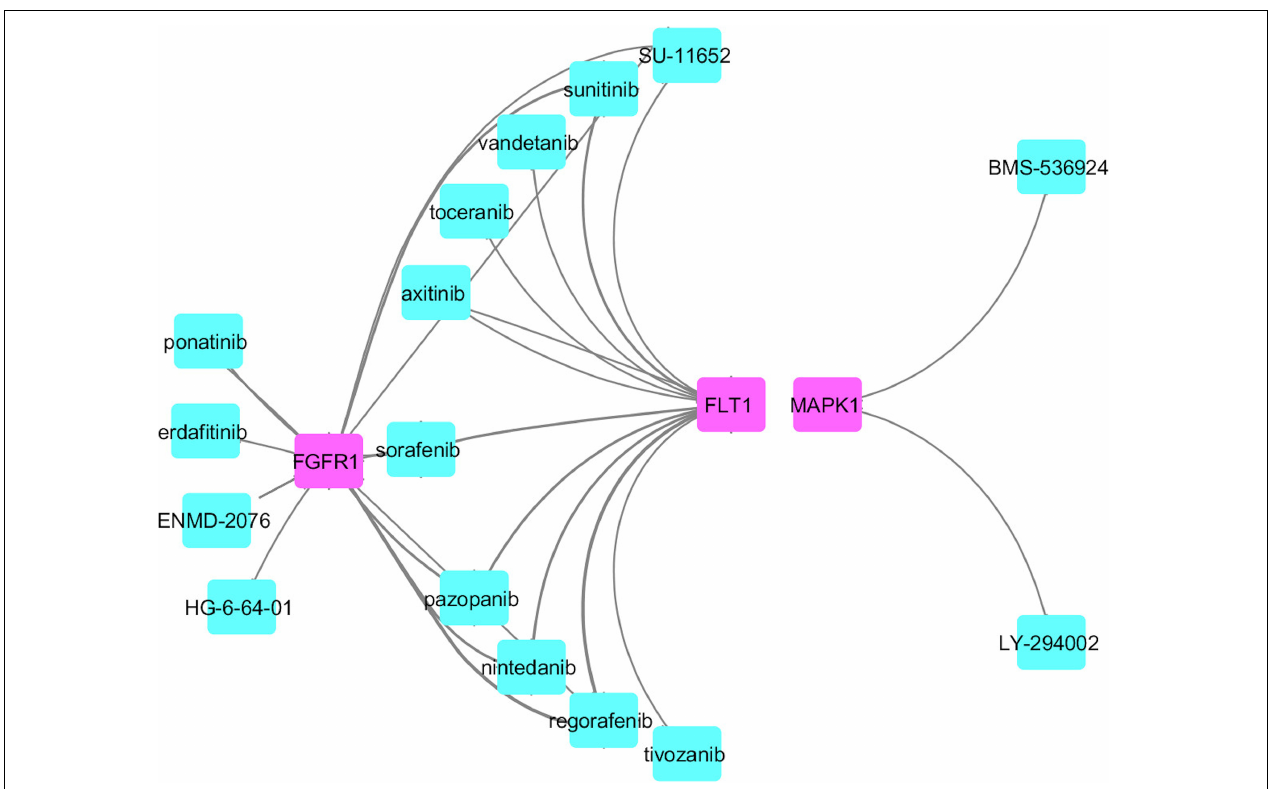
FIGURE 6 | Drug connectivity map along with the proposed possible drug